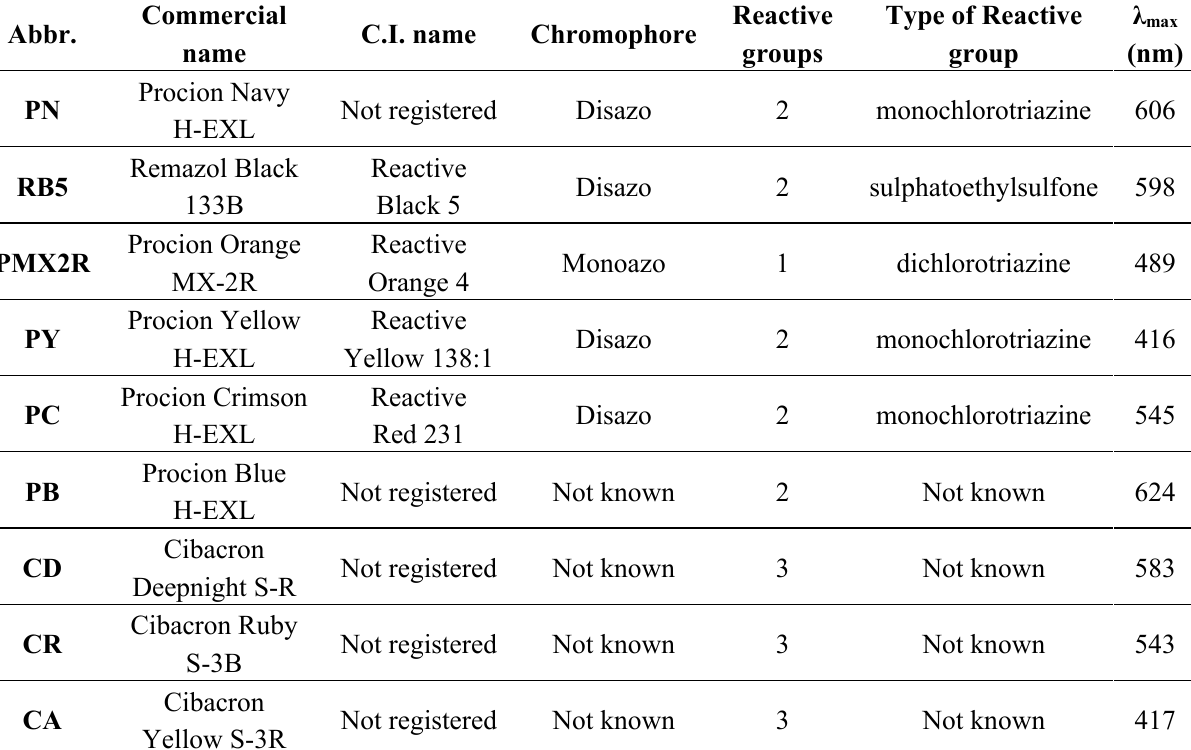
Table 5. Description of selected Reactive